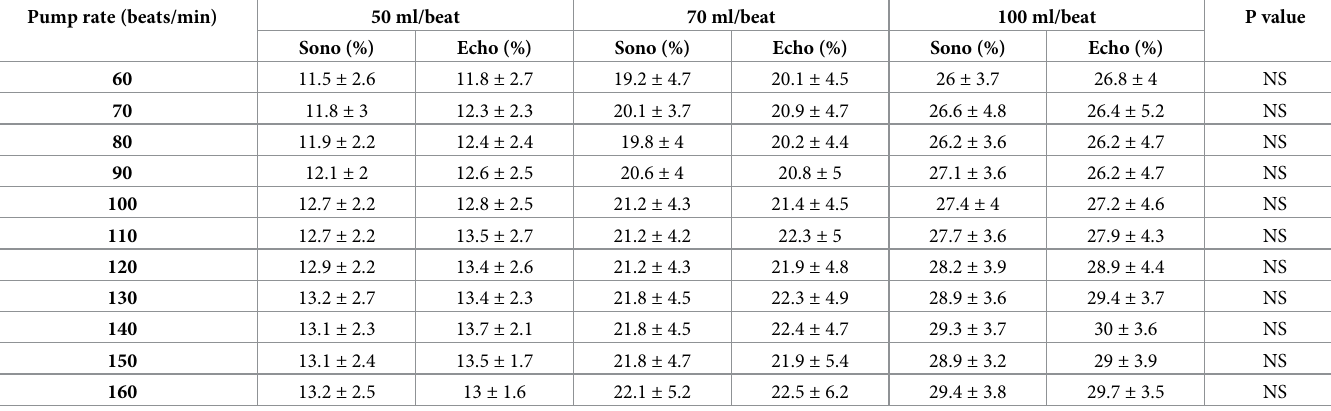
Table 1. Comparison of the mean radial strain values by sonomicrometry and by speckle tracking. Pump rate (beats/min)